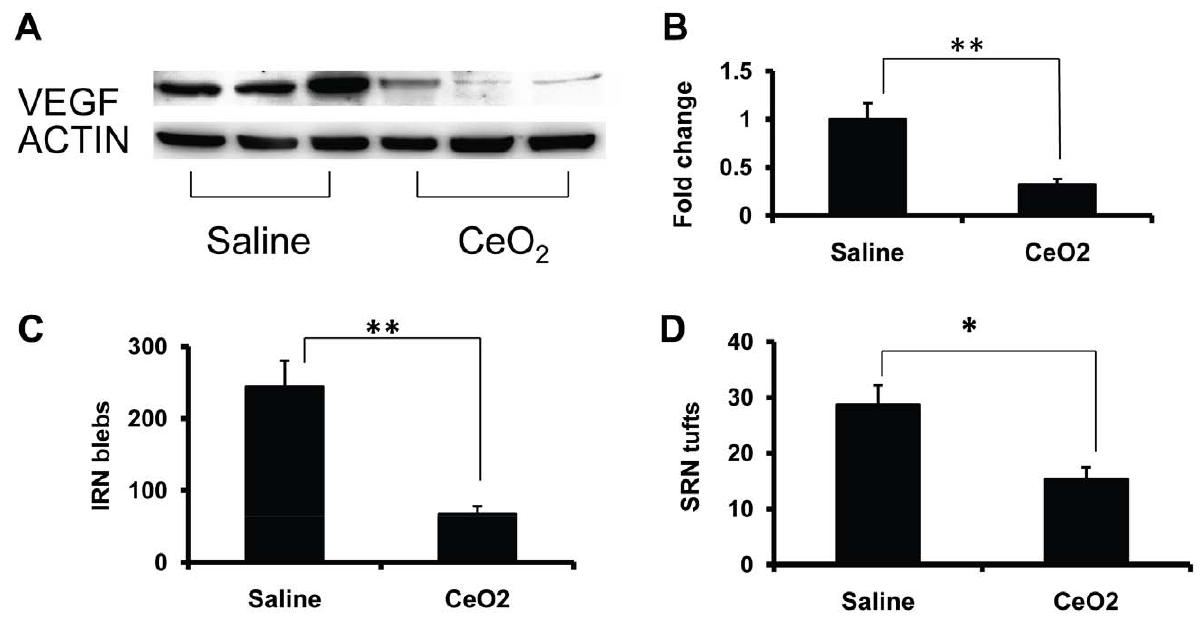
Figure 6. Retinal vascular lesions in the Vldlr-/- retinas require continual production of excess ROS. Vldlr-/- mice were injected at P28 with saline or nanoceria and killed one week later on P35. Analysis of VEGF levels by Western blots ( A ) showed a four-fold reduction ( B ) within one week of nanoceria injection. The numbers of IRN blebs ( C ), and SRN tufts ( D ) were also dramatically reduced. * p , 0.05; **p , 0.01.